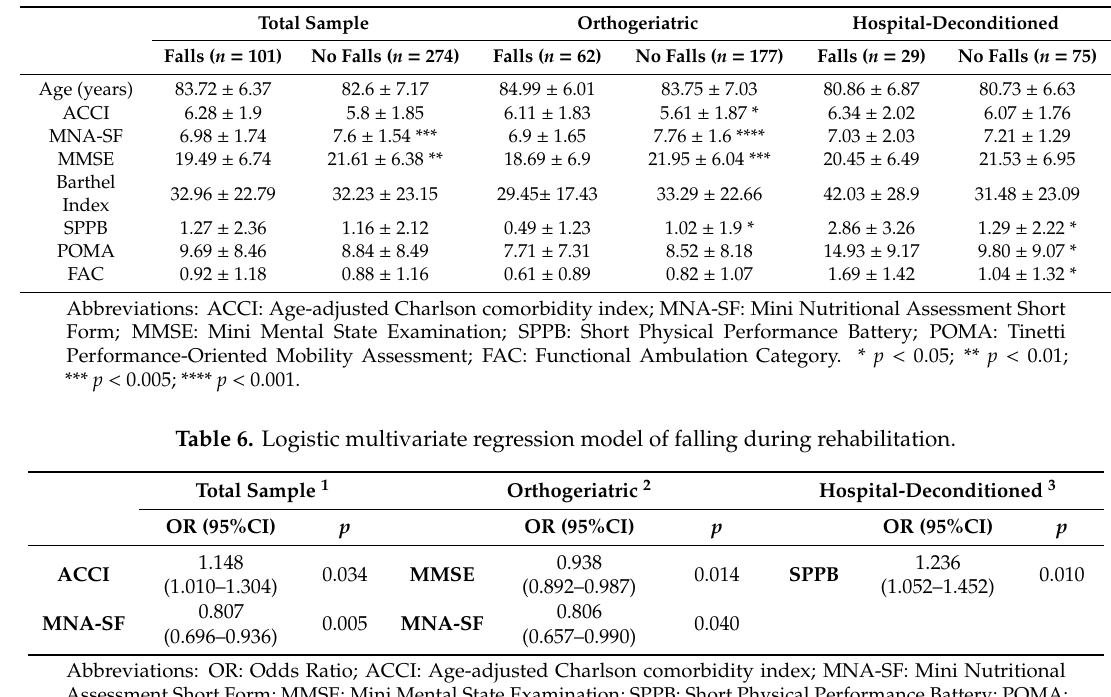
Table 5. Baseline characteristics of the sample according to falls.